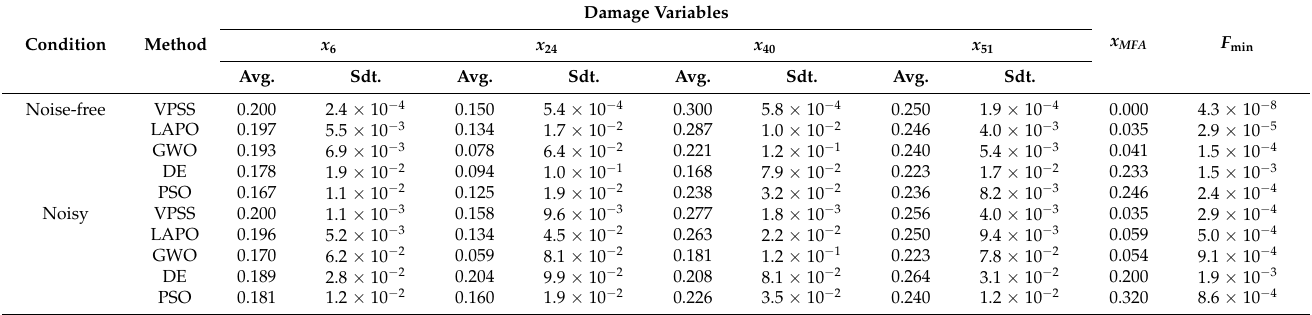
Table 4. Statistical results of the damage identification for the 54-bar space truss.